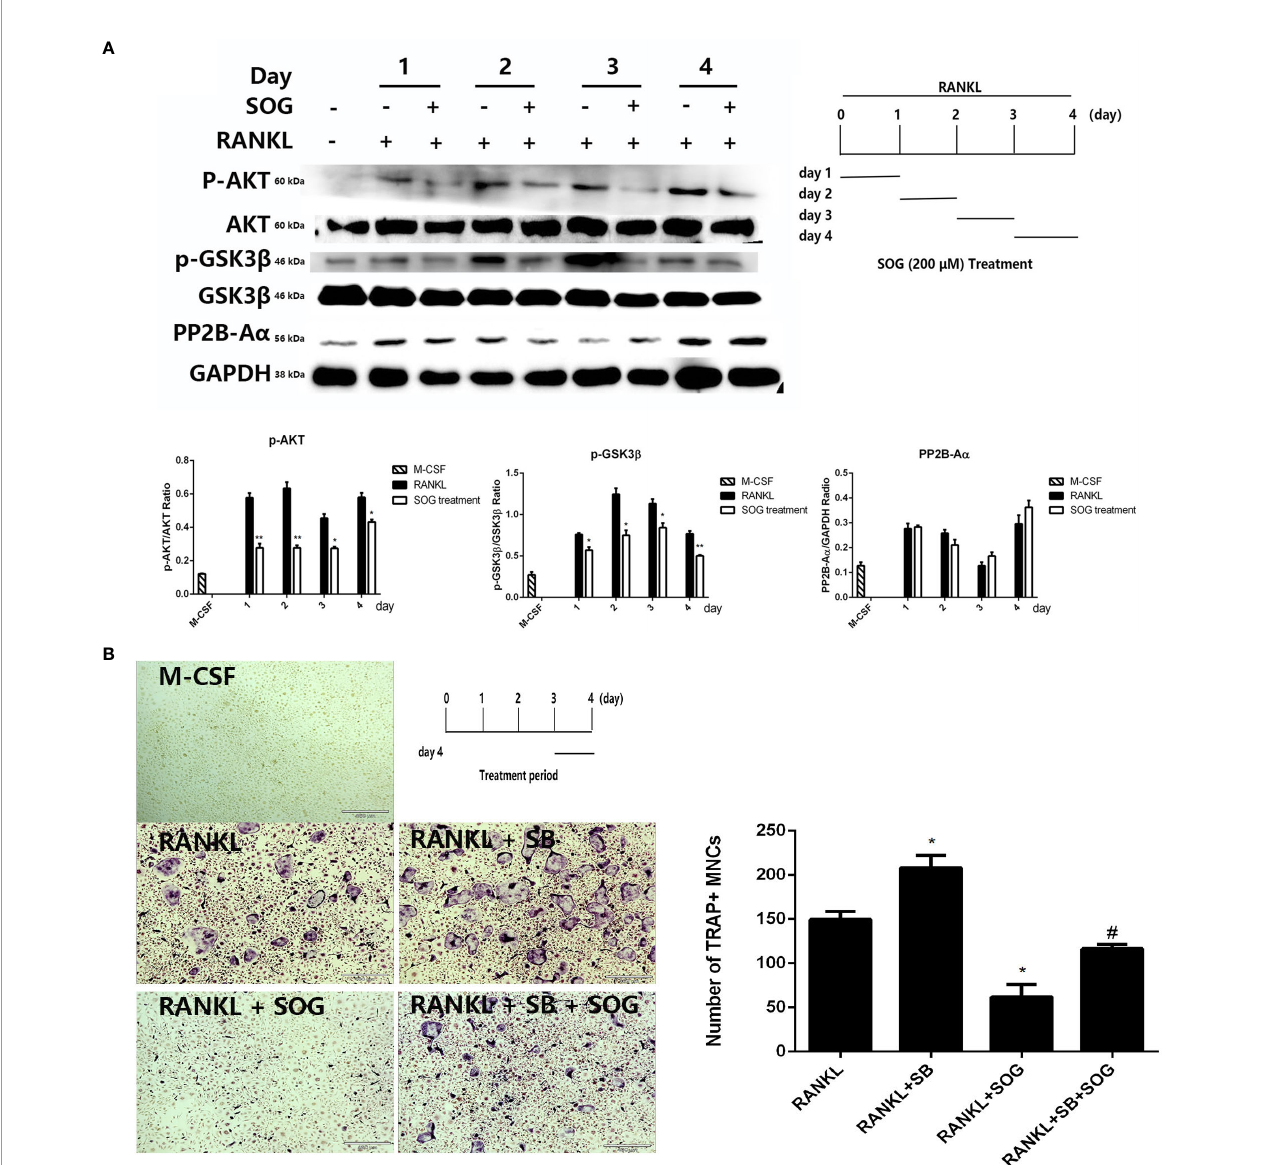
FIGURE 5 | The effect of SOG on RANKL-induced calcineurin expression and the AKT-GSK3 b signaling pathway. (A) Protein levels of calcimeurin, AKT, and GSK3 b in BMMs at different periods of osteoclastogenesis cultured with M-CSF, RANKL, and SOG, as determined by western blotting (left panel). The SOG treatment time is shown in the lower right panel. (B) TRAP staining of BMMs cultured with M-CSF, RANKL, and SOG or SB415286 (SB) at d 3 of osteoclastogenesis (left panel). The SOG treatment time is shown in the upper left panel. TRAP + cells with ≥ 3 nuclei were counted (right panel). 40× magni fi cation. Scale bars, 460 m m. All experiments were performed in duplicate at least three times. * p < 0.05 and ** p < 0.01, versus RANKL-induced group. # p < 0.05 versus RANKL + SB-induced